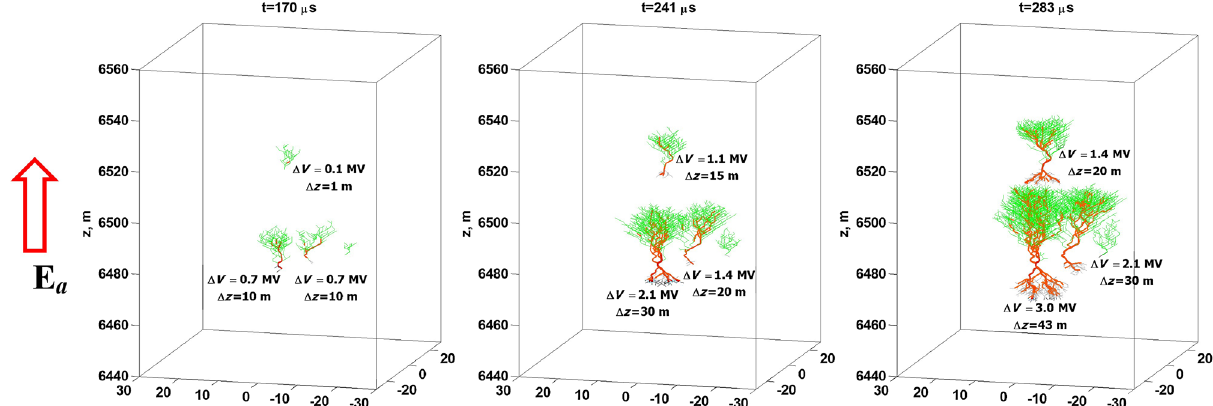
Figure 4. An example of the evolution (three snapshots) of 3D streamer/hot-channel systems in a uniform upward-directed electric field E a = 70 kV/m. Channel segments with conductivities higher than 1 S/m (assumed to be “hot”) are shown in red. Ambient potential differences (cid:31) V bridged by hot channel segments and their vertical lengths (cid:31) z (same as L in the text) are given in each panel. All three axes are labeled in